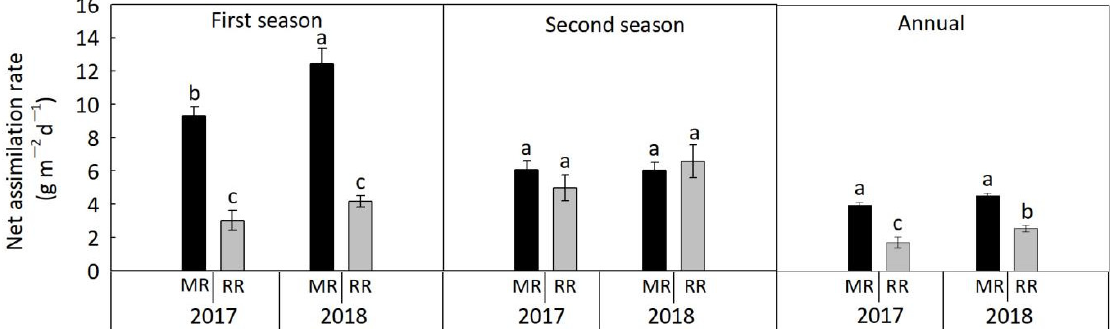
Figure 3. Net assimilation rate for crops under MR and RR cropping systems at Wuxue from 2017 to 2018. Different letters indicate significant differences between values within the same column in the same season according to the least significant difference (LSD) test ( p < 0.05). MR: maize–rice cropping system; RR: double-rice cropping system.